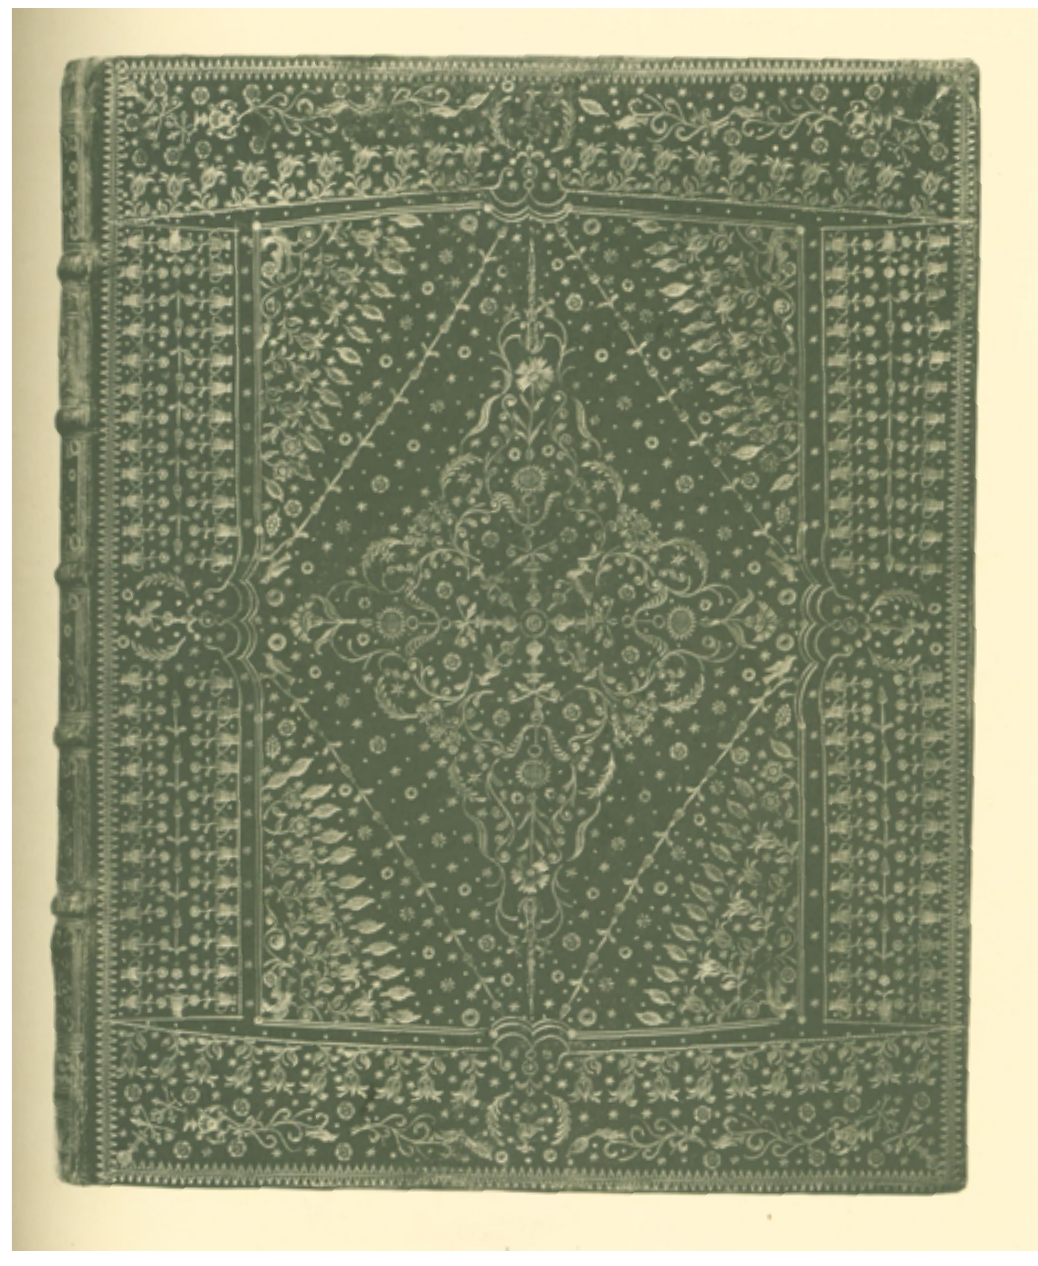
Fig. 37. One Hundred and Seventy-Six Historic and Artistic Bookbindings ... from the Library of Robert Hoe (New York, 1895), plate 131. The oval flower headed sunflower with a circle beneath and two leaves protruding from the central stalk, repeated four times in the centre piece, has proven useful in identifying other bindings from this workshop. See fig. 38 for an enlargement of the sunflower